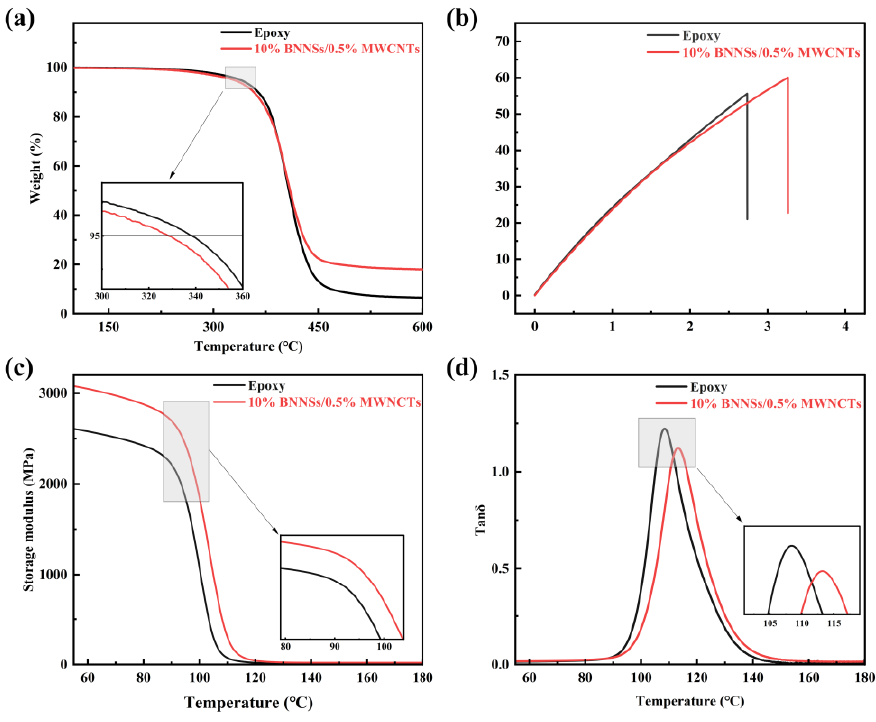
Figure 5. ( a ) TGA curves (all samples contain SiO 2 @KH560). ( b ) Stress – strain curves (All samples contain SiO 2 @KH560). ( c , d ) DMA curves.